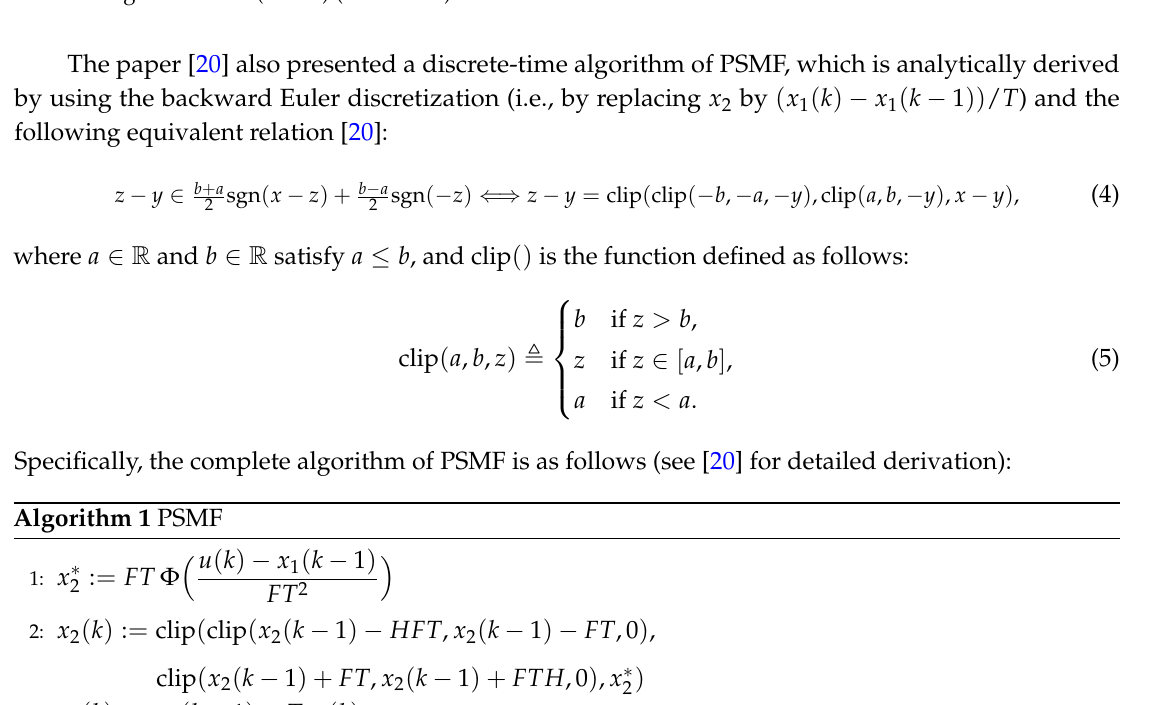
Figure 1. The parabolic-shaped sliding surface (thick curve) and trajectories of the state of parabolic sliding mode filter (PSMF) (thin